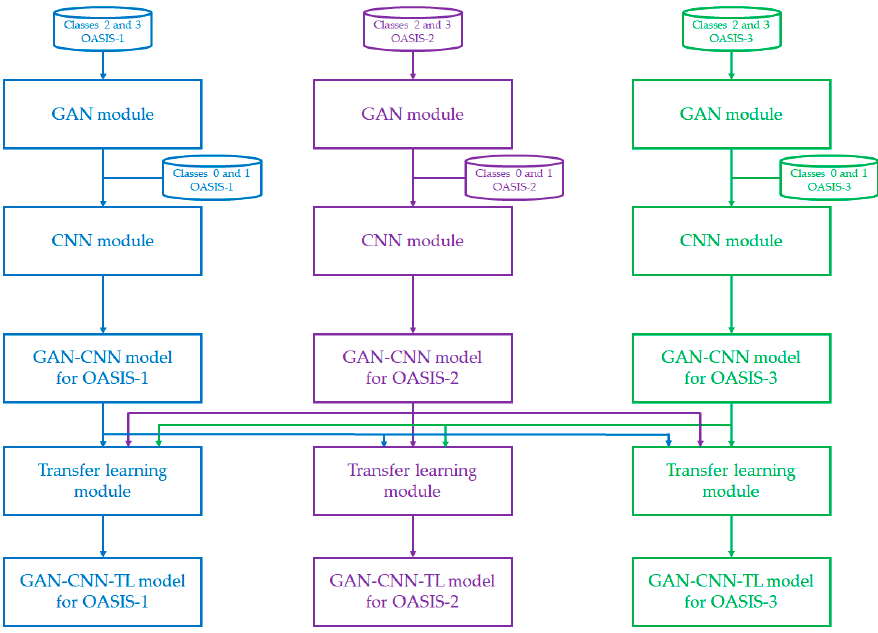
Figure 1. Conceptual diagram of the proposed GAN-CNN-TL algorithm for AD detection.